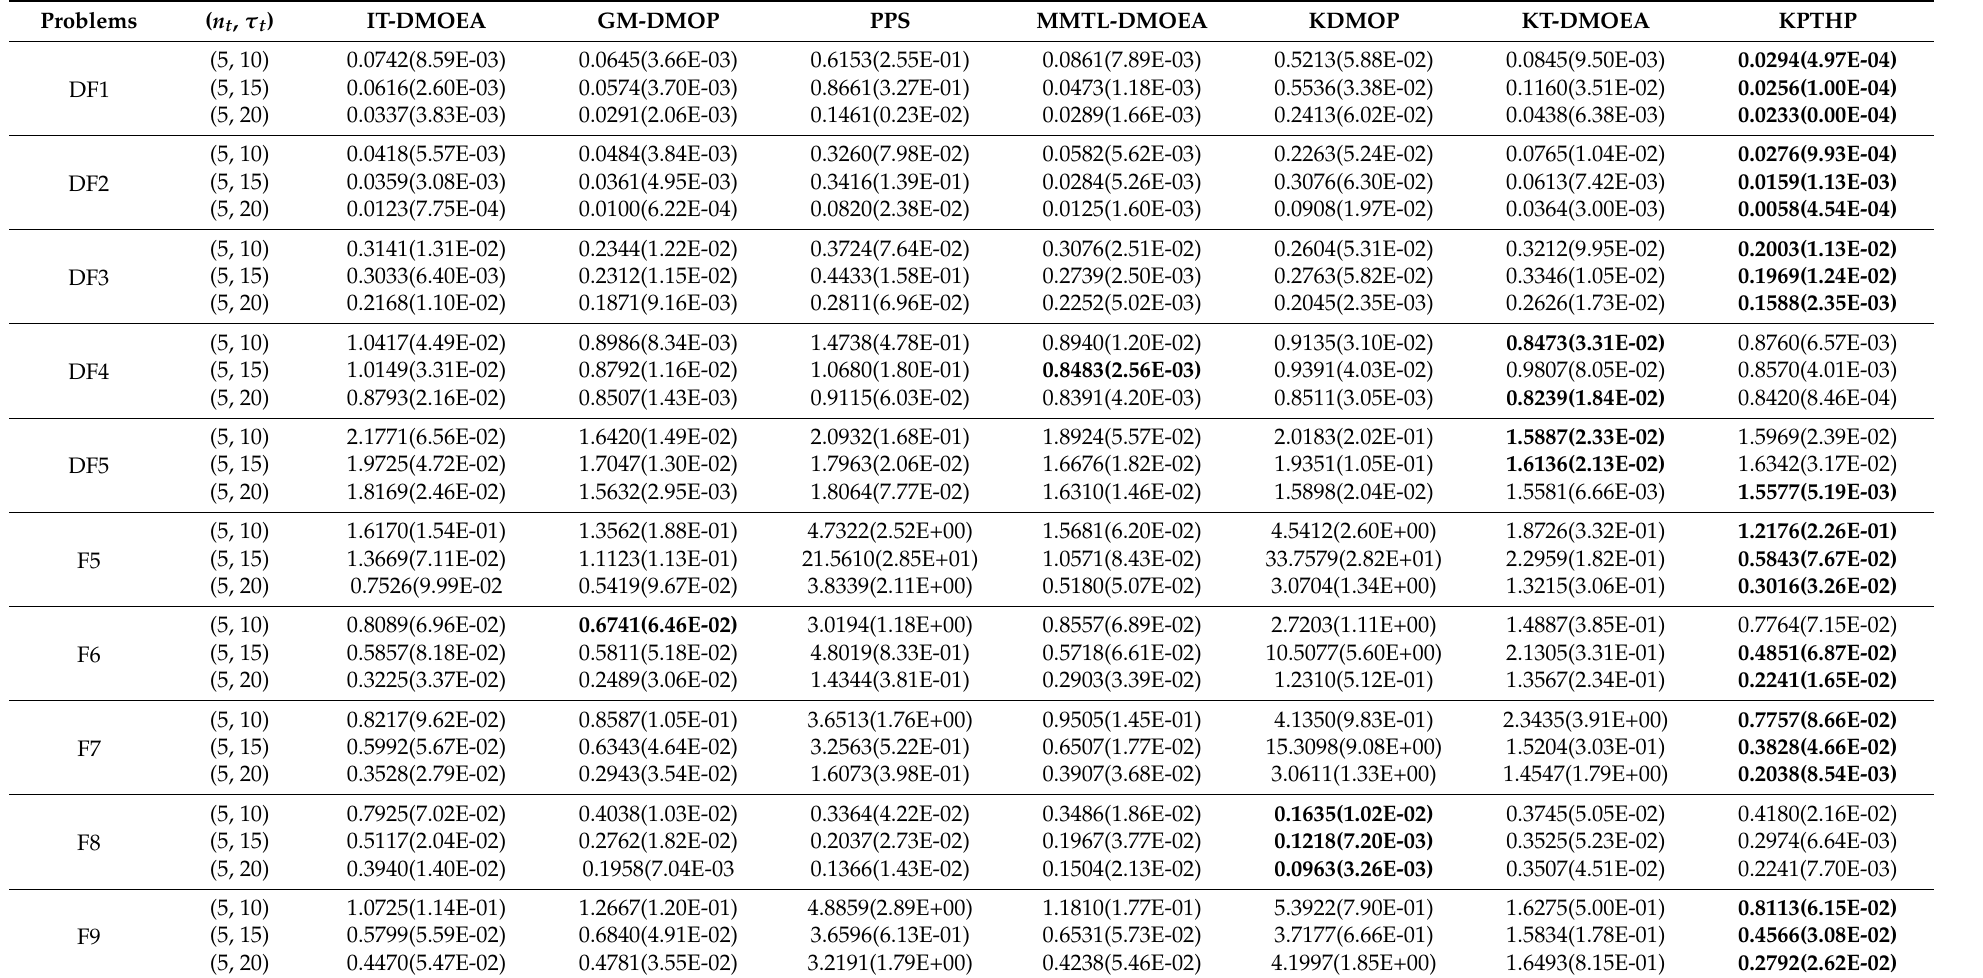
Table 6. Mean and SD of MIGD indicator obtained by seven algorithms for ( n t , τ t ) = (5, 10), (5, 15), and (5,